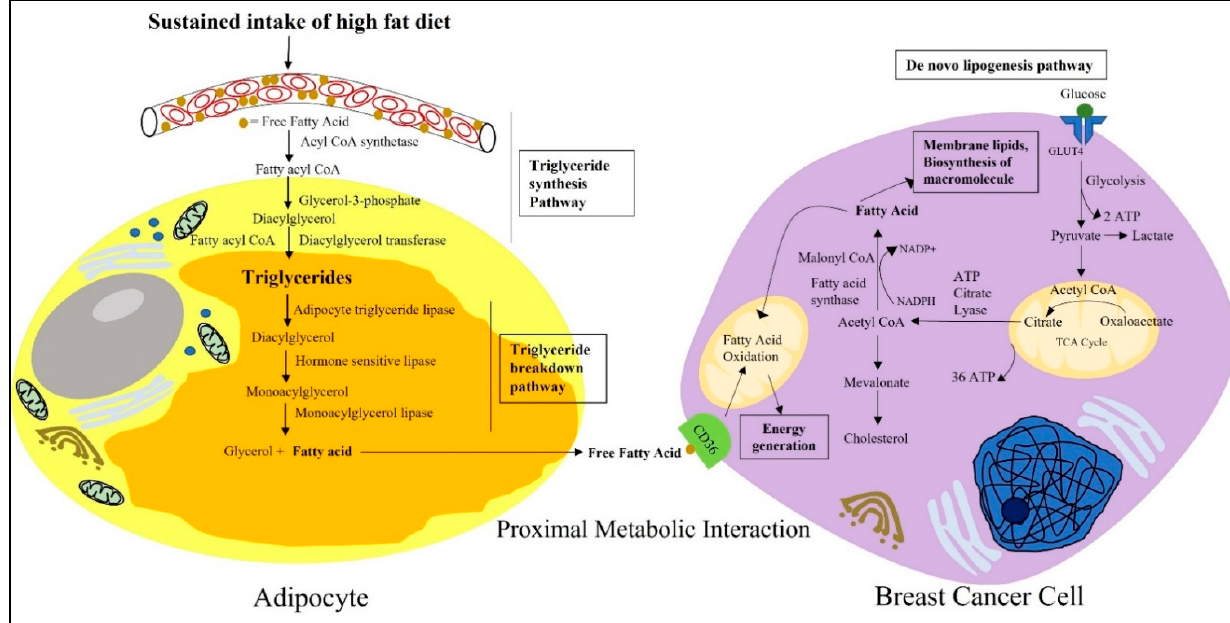
Figure 2. Schematic representation depicting the proximal metabolic interactions between adipocytes and breast cancer cells. Fatty acids are the unit molecules of fat, present in excess in the blood plasma of obese individuals. As free FAs can be toxic at higher concentrations, they are stored in the cytosolic lipid droplets of white adipocytes in the form of triglycerides following the triglyceride synthesis pathway. Due to excess energy demands and metabolic requirements, breast cancer cells can mobilize these stored fats from surrounding adipocytes and use them to compensate for their energy needs. Breast cancer cells use the fat in the form of fatty acids that are derived from the triglycerides stored in white adipocytes. Free fatty acids released from white adipocytes are then taken up by breast cancer cells through the transmembrane channel protein CD36A present on its cell surface. Apart from that, breast cancer cells are also able to generate fatty acids from blood-derived glucose following de novo lipogenesis pathways. Breast cancer cells then use the unit molecule of fatty acids to fulfill their ever-expanding metabolic needs, to synthesize new macromolecules and membrane lipids.